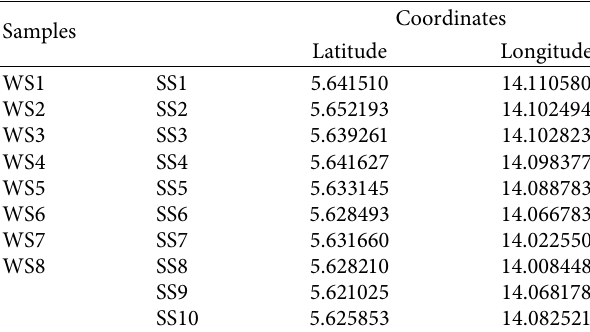
Table 1: Geographical coordinates of samples.